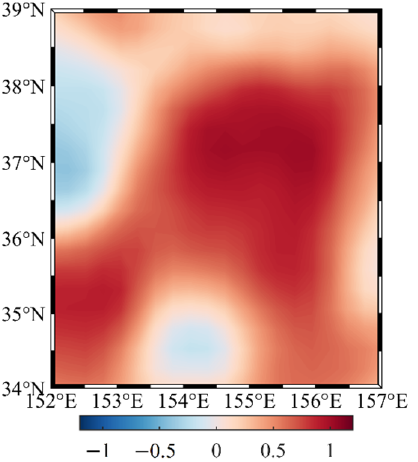
Figure 4. Annual range of the global sea level anomalies in 2020 (unit: m). Table 1. Parameters of the sea level anomaly data in the study area. Lat. and